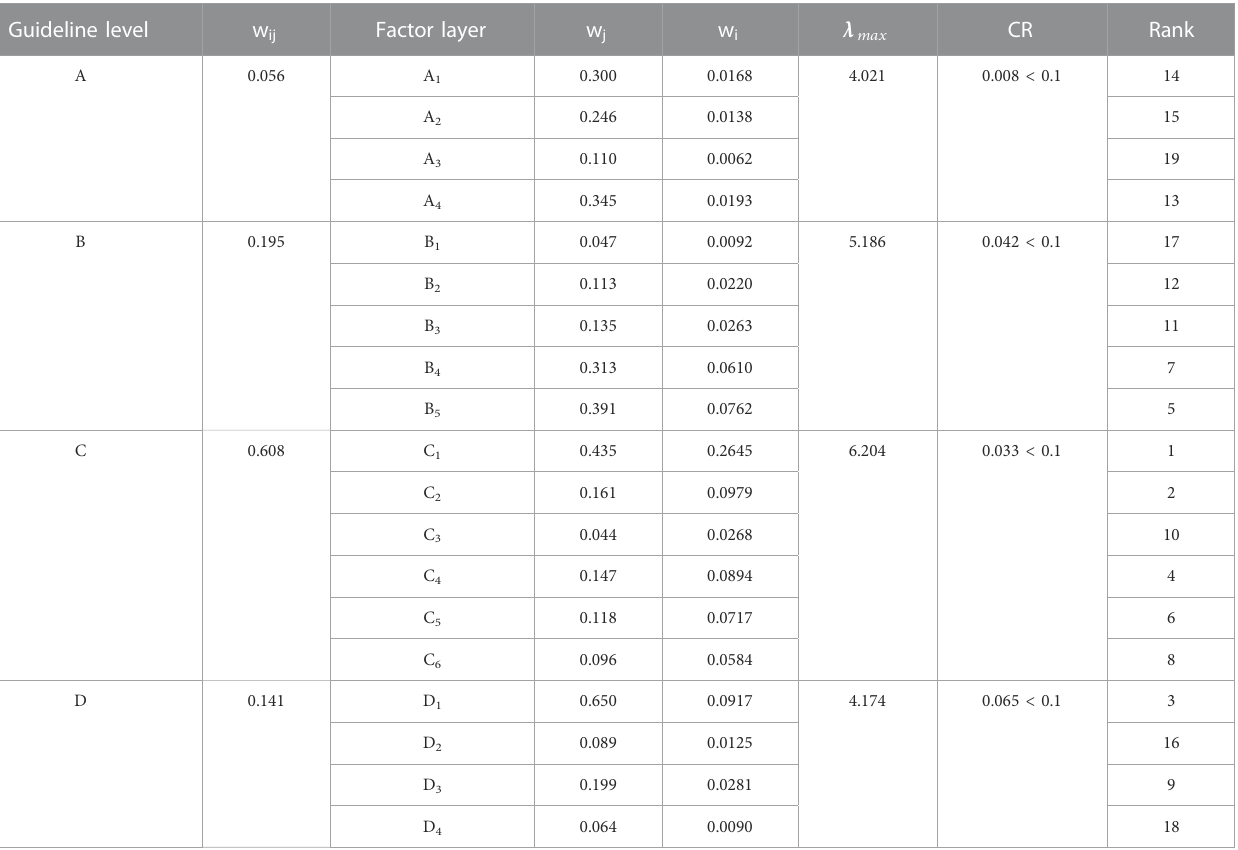
TABLE 20 Standard weight and total ranking of target layer